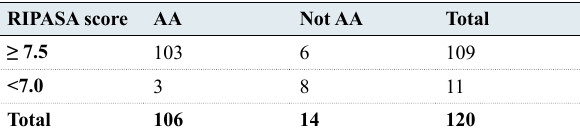
Table 5: Sensitivity & specificity of RIPASA score categories RIPASA score